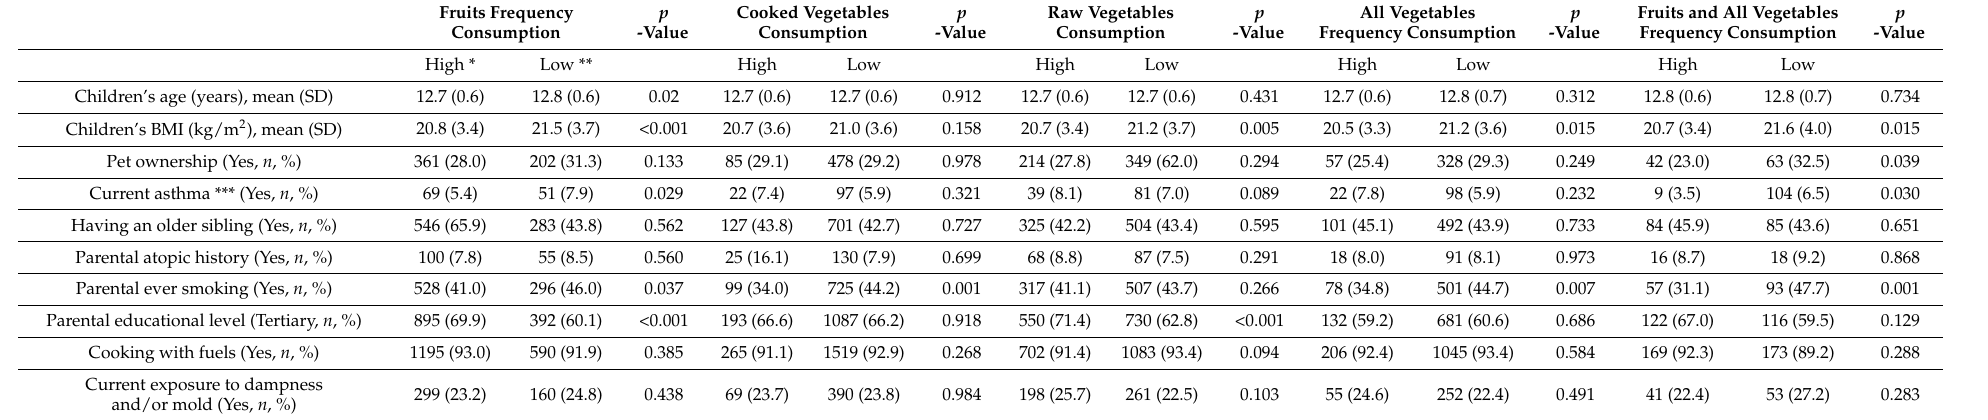
Table 2. Adolescents’ demographic, anthropometric, parental and home environment characteristics according to the consumption frequency of fruits, cooked vegetables, raw vegetables, all (cooked and raw) vegetables, and fruits and all vegetables in the past 12 months ( n =